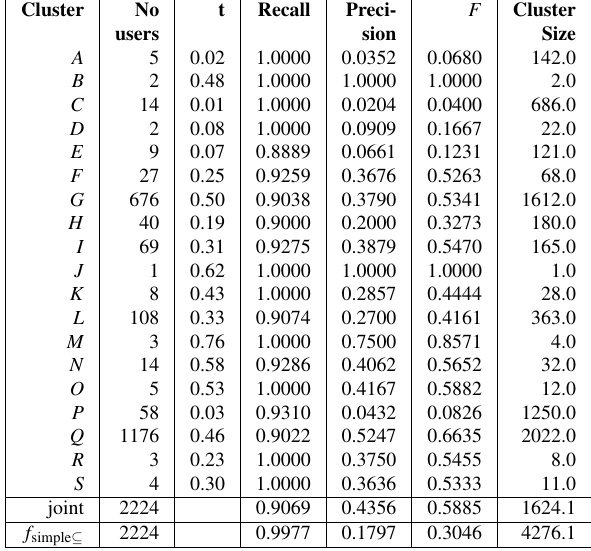
Table 5. Optimal parameters of f t classifier and its performance on single categorial clusters. Last verse describes classifier on all single categorial clusters